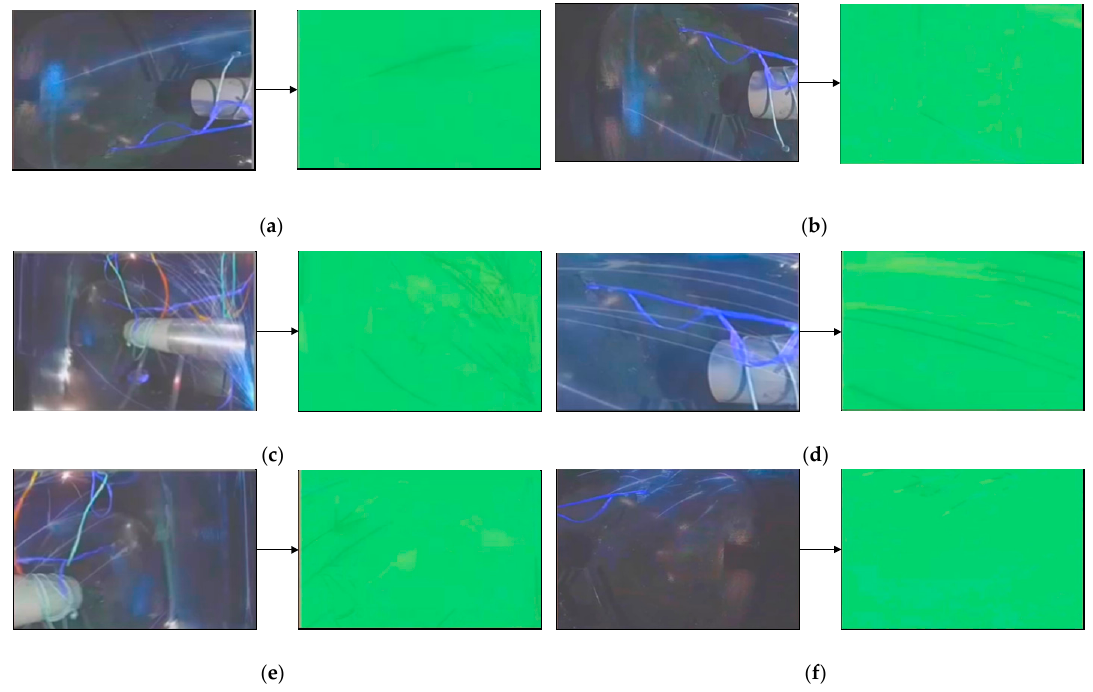
Figure 17. ( a – f ) show the visualization results of aero engine images with anomalous sparks, generated by the encoder and decoder at six different moments. The visualization method scales each value of the three-channel two-dimensional tensors, output by the activation function, into the interval from 0 to 255, and displays it as an RGB image. The deep feature images only include the spark texture features.